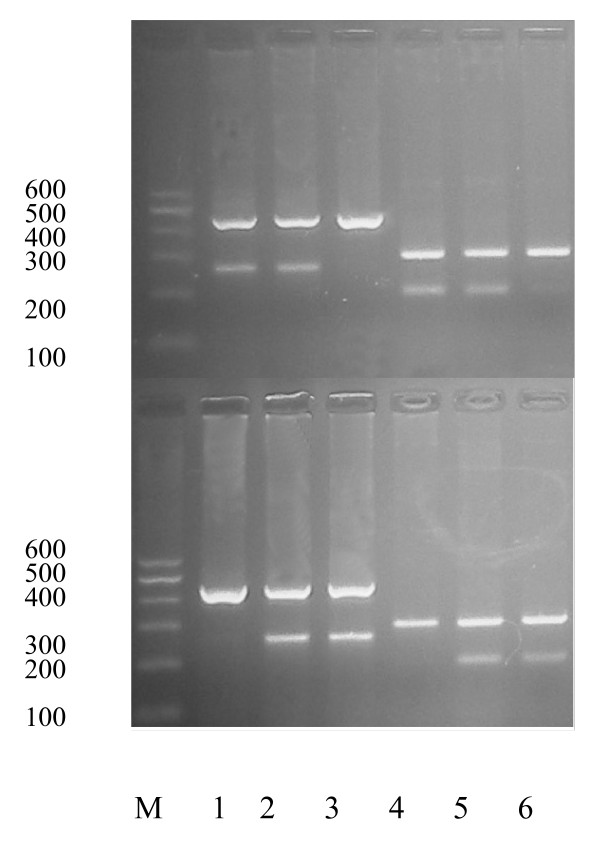
Genotyping for the IL-18 position -137 and -607 polymorphisms. M: DL600 DNA Marker; lanes 1-3: -137 GG, GC and CC; lanes 4-6: -607 CC, CA and AA.